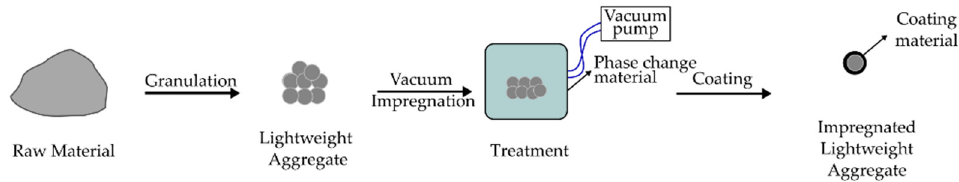
Figure 7. Vacuum impregnation. Figure 7. Vacuum